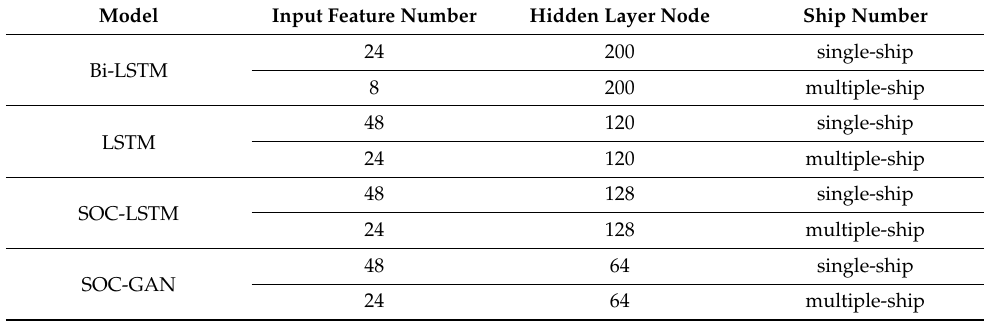
Table 3. Network parameter settings for different models.